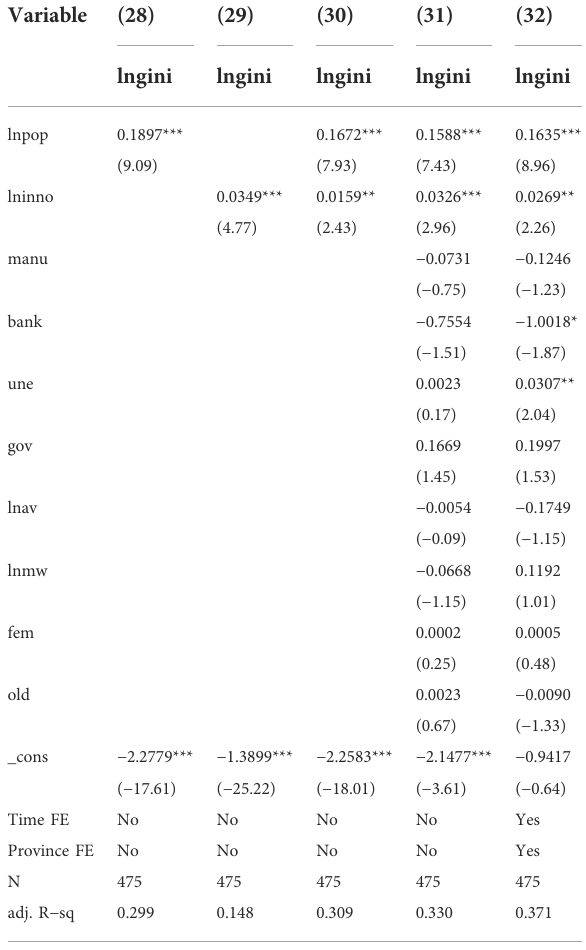
TABLE 10 Robustness tests: changing the sample